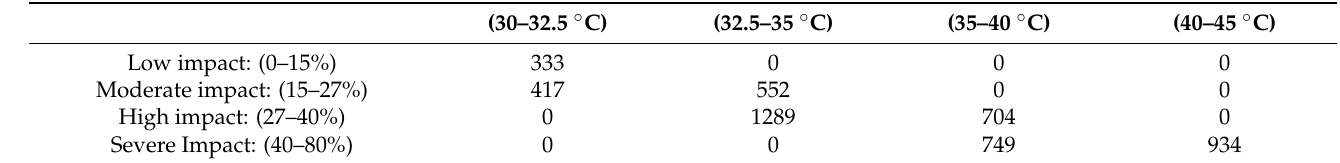
Table 2. Contingency table cross-referencing the yield loss prediction classes with the maximum temperature classes recorded on 28th June